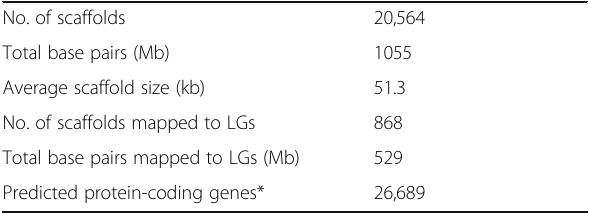
Table 1 Assembly statistics of the Japanese eel